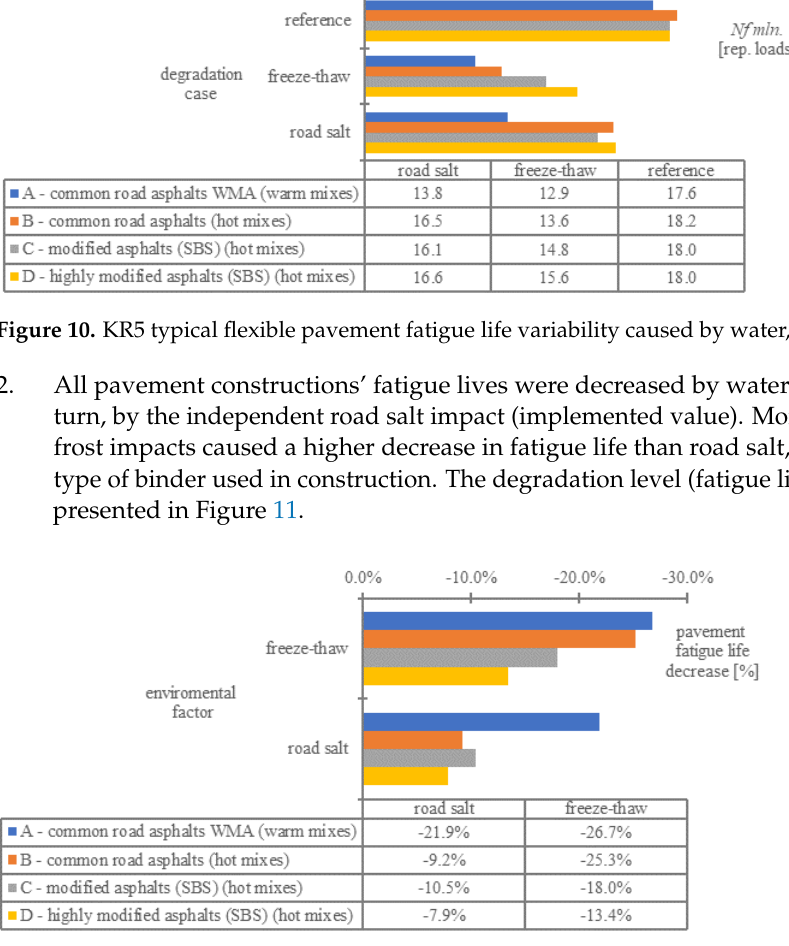
Figure 11. The impact of road salt, water, and frost on pavement reduces its fatigue life. 3.